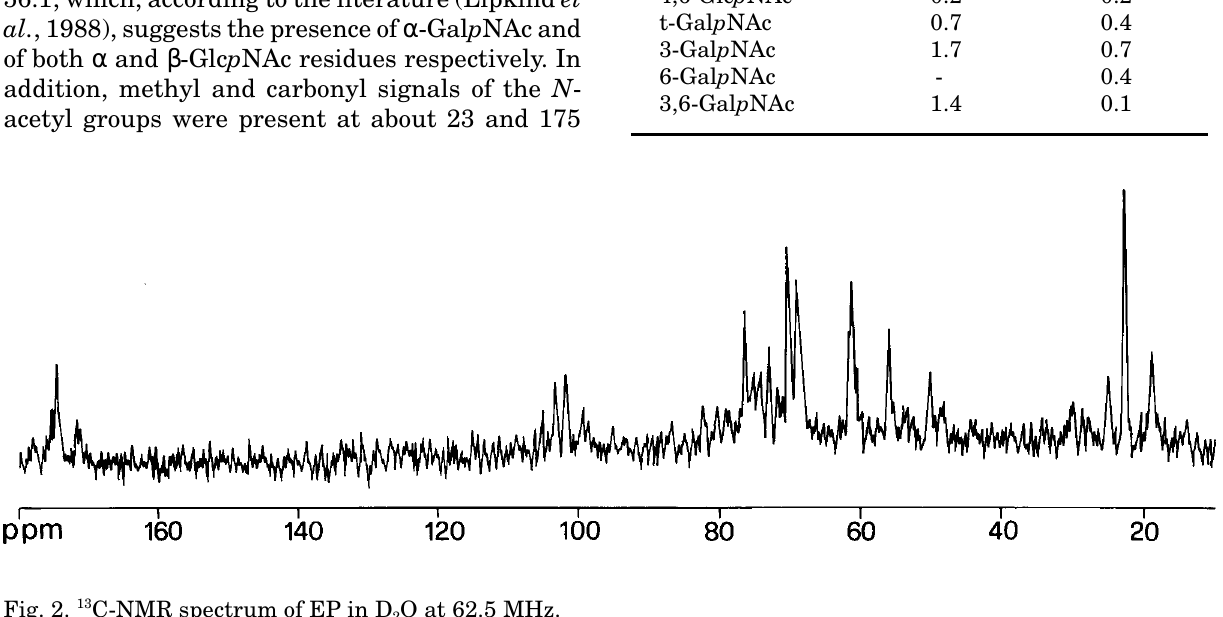
Fig. 2. 13 C-NMR spectrum of EP in D